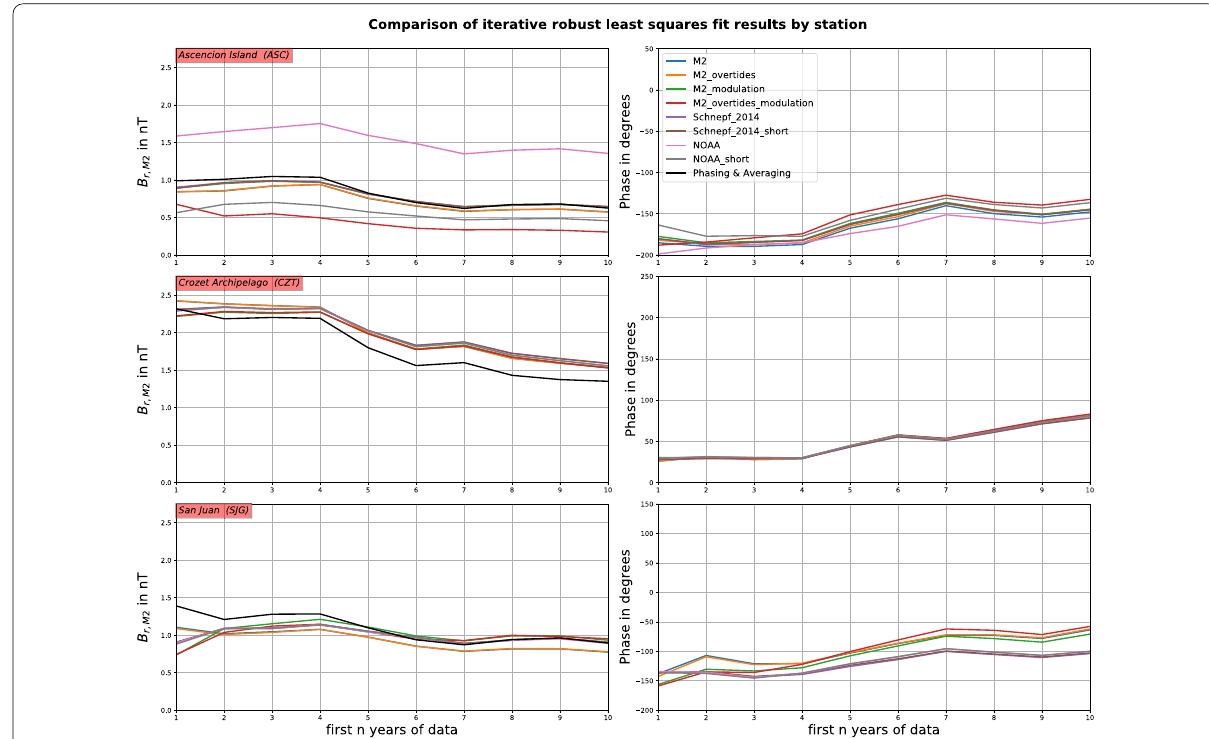
Fig. 5 Comparison of oceanic M2 tide induced magnetic field signal parameters extracted from the residual data by fitting different harmonic sums using an iterative robust least squares approach. The left column shows the extracted amplitudes and the right column the extracted phases in dependence of analysed time series length. In contrast to the previous figures, only the analysis of the first n years of the 10 year time series are presented because of the computational costs of this analysis and the evident conclusions that can be drawn from these presented results. Black lines in the left column show the results obtained by phasing and averaging the residual data and allows for a comparison of both methods. Please note, on the right‑hand column the y‑scales vary by row. This choice was made to increase presentability of the obtained results. Root mean square values of the residual data for each data point, i.e., for each the fit made with each fit function to the given time span is summarized in the Additional file 1 under Tables